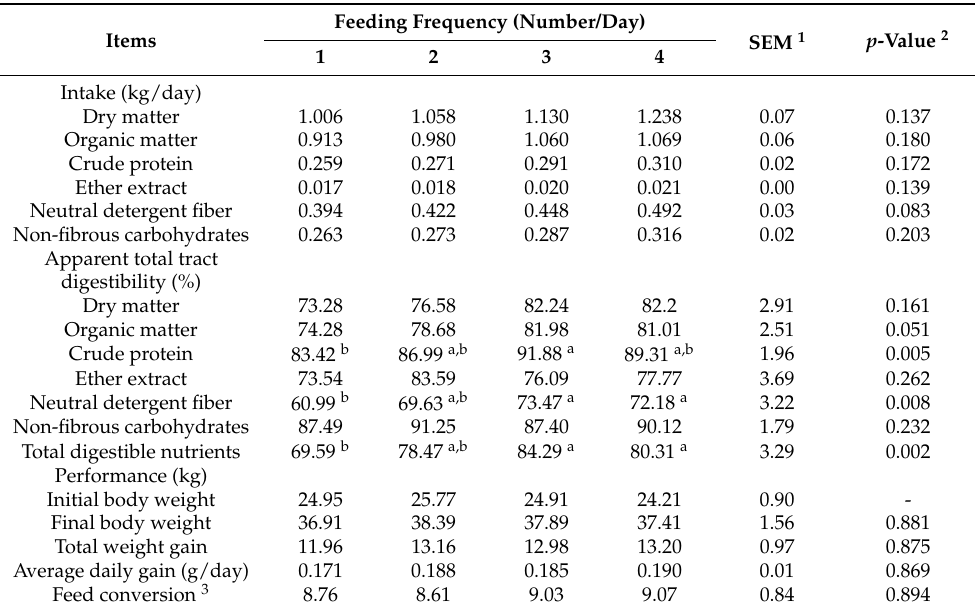
Table 2. Intake and digestibility of nutritional components and performance of male feedlot lambs subjected to different feeding frequencies. Feeding Frequency (Number/Day) Items